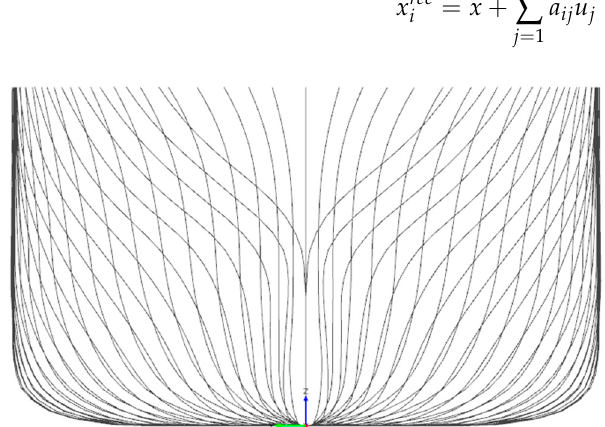
Figure 6. Contribution rates of the 10 largest eigenvalues.